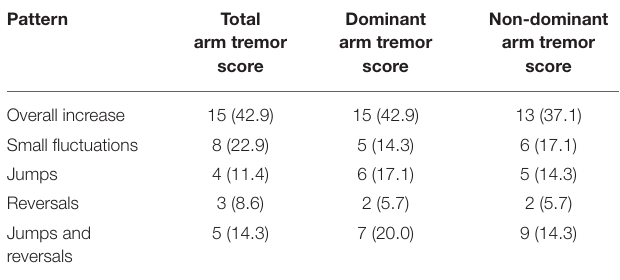
TABLE 3B | Frequency of tremor progression patterns following scheme 2